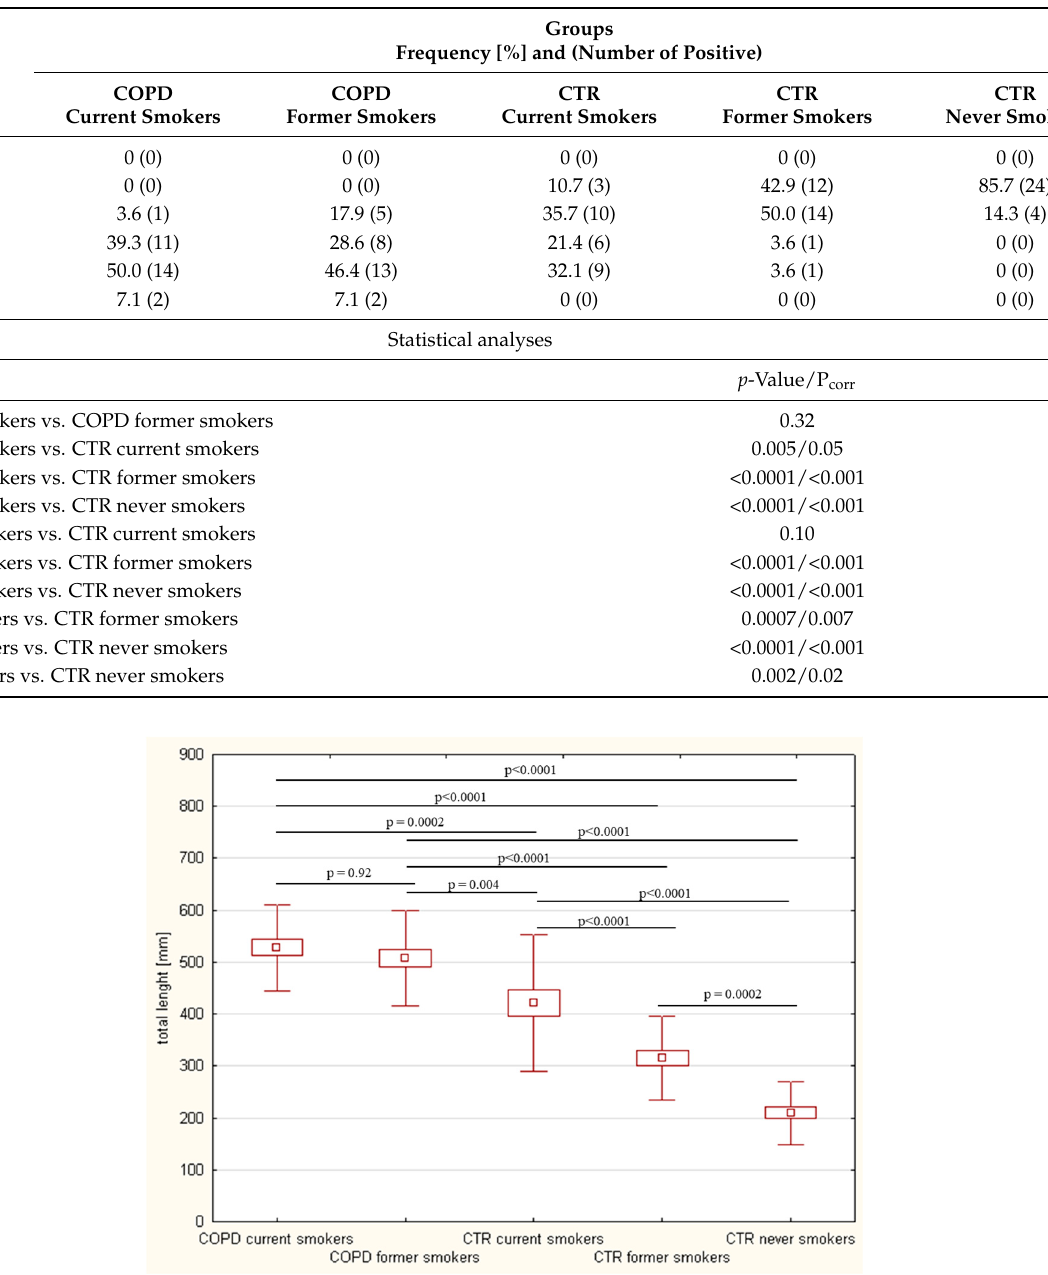
Figure 1. Total length of the wrinkles in the analyzed groups. Moreover, relationships between total wrinkle length and lung function parameters, as well as anthropometrical data, were calculated. There were no significant relationships between total wrinkle length and age and BMI. However, as shown in Figure 2, there were negative correlations between the length of wrinkles and FEV1 and FEV1/FVC (% of predicted), with r-values estimated as − 0.77 and − 0.58 (for FEV1% and FEV1%/FVC,